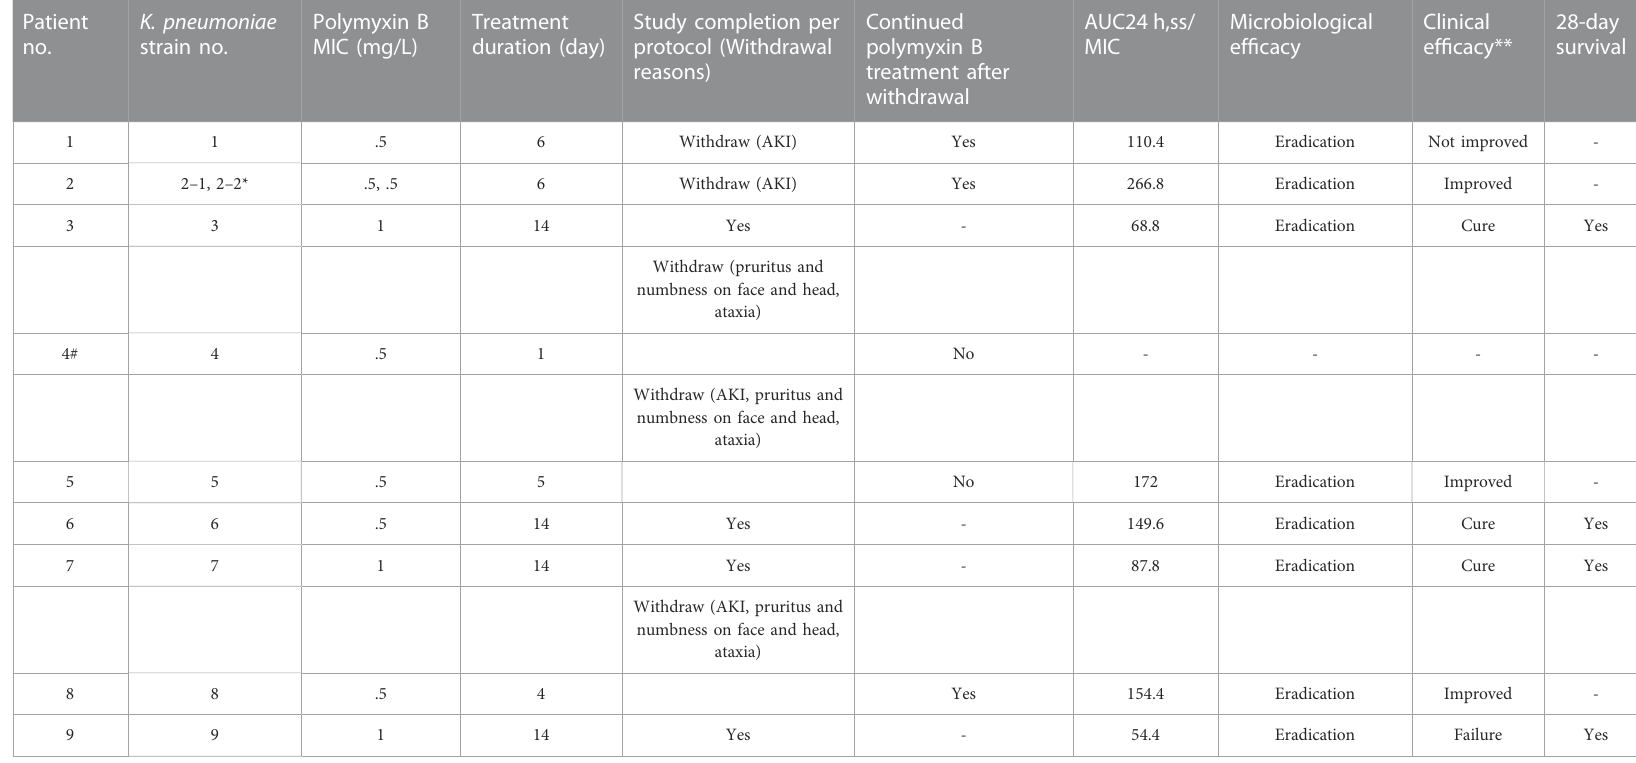
TABLE 1 Polymyxin B MICs, pharmacokinetic/pharmacodynamic indices, and clinical outcome. Patient